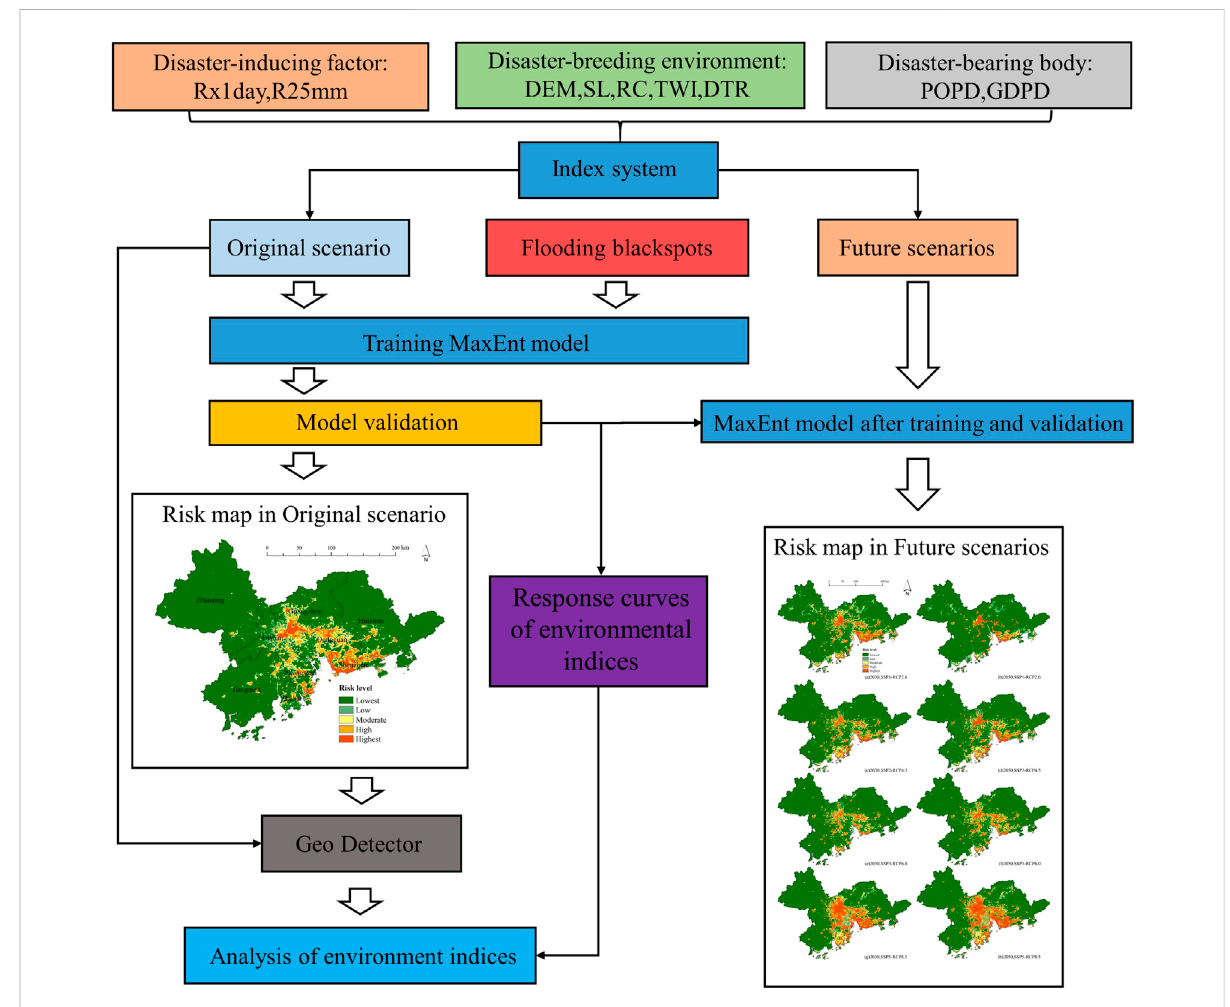
FIGURE 2 The fl owchart of fl ood risk assessment and projections in this